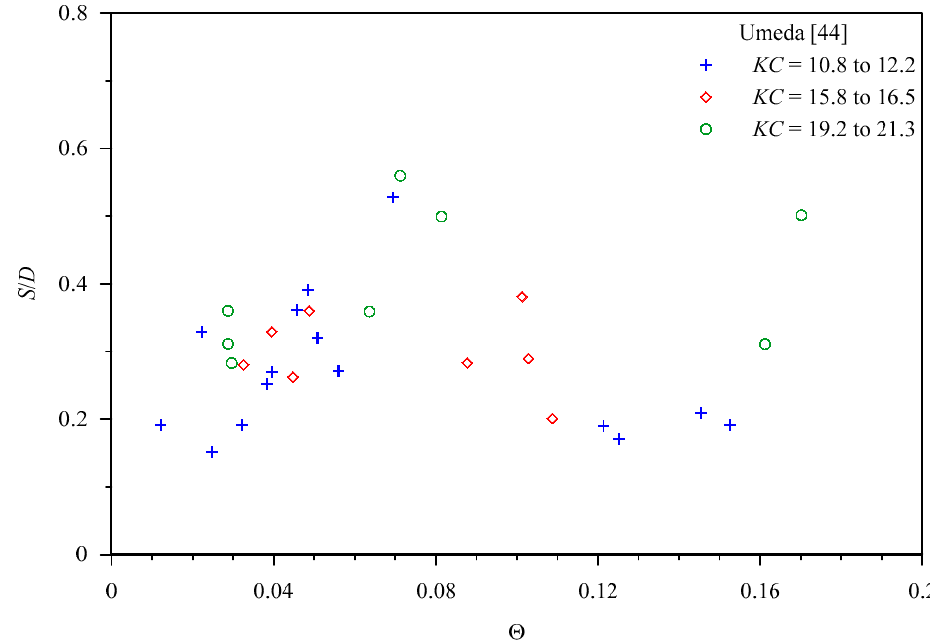
Figure 6. Variation of nondimensional scour depth, S / D , with Shields parameter, Θ , for different sets of KC numbers under waves.